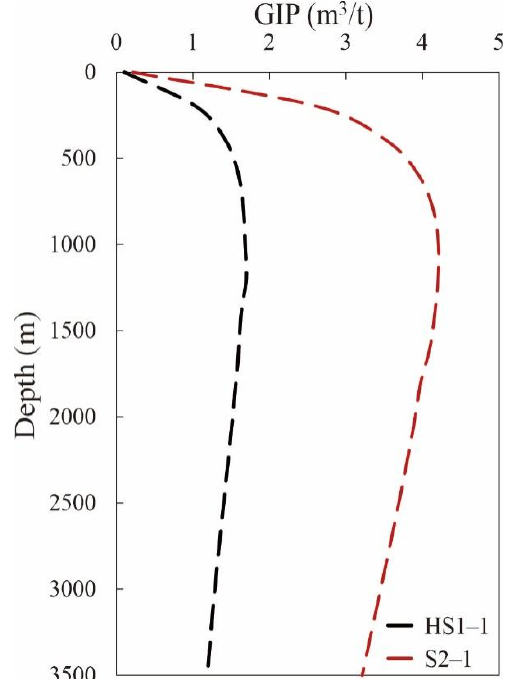
Figure 8. GIP profiles as a function of depth.